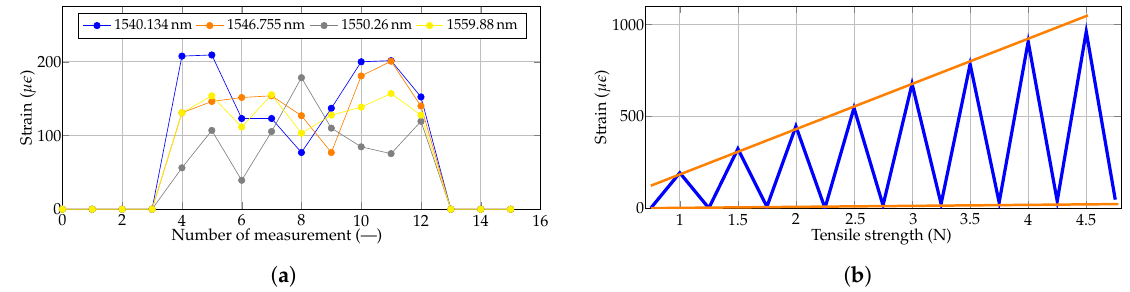
Figure3. Strainchangescausedby: a)6kgload,andb)tensilestrengthcausedbyaforcegauge.